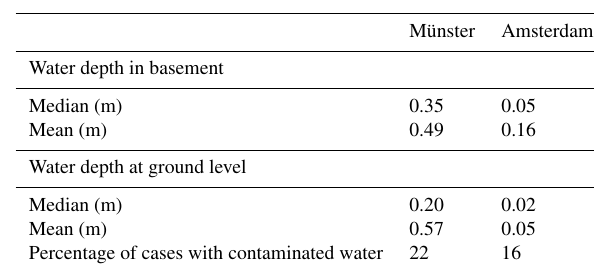
Table 5. Reported water depths and contamination. Median and mean are based on non-zero values of the water